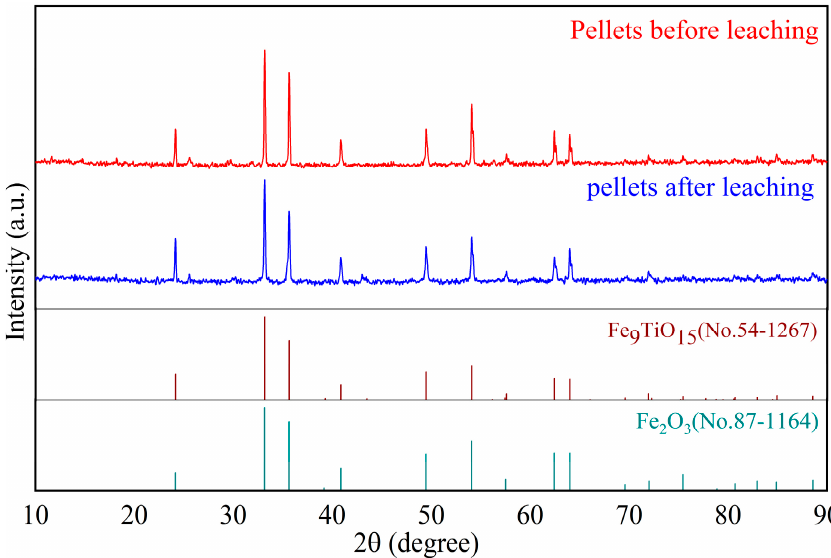
Figure 5. XRD patterns of before and after leaching pellets.